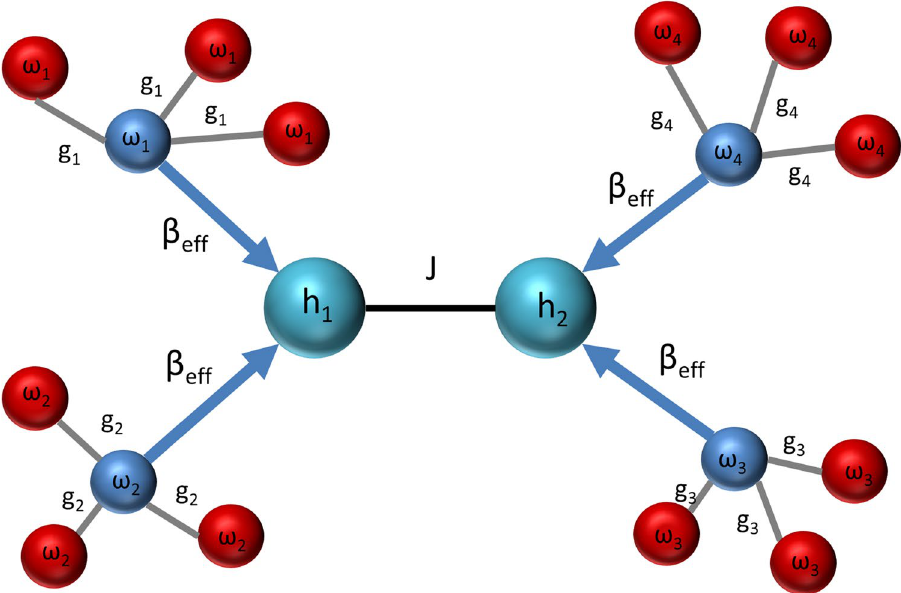
Figure 4. Sketch of a Markovian collision model cooling a two-spin longitudinal Ising model described by the Hamilonian in Eq. (16), with coupling strength J , using four spin-star quantum refrigerators labeled with i = 1 . . . 4 . Central qubits of the refrigerators are the refrigerants at effective inverse temperature β eff . Central qubits are not resonant with the Ising model qubits, whose energy gaps are denoted by h 1 and h 2 , instead, they are resonant with the transition frequencies ω i ( i = 1 . . . 4 ) of the Ising model. Spin-star model has longitudinal and homogeneous couplings g i